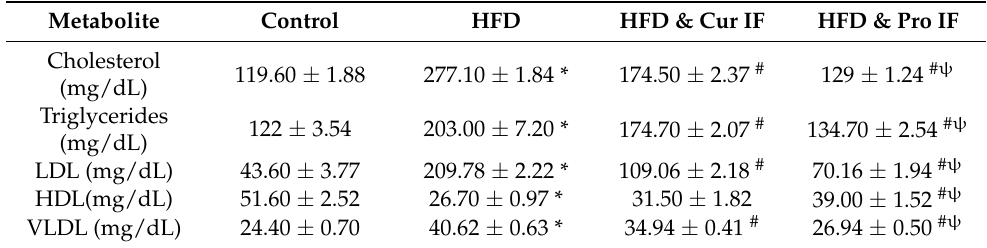
Table 3. Effects of HFD and IF on serum lipid profile of all experimental groups.